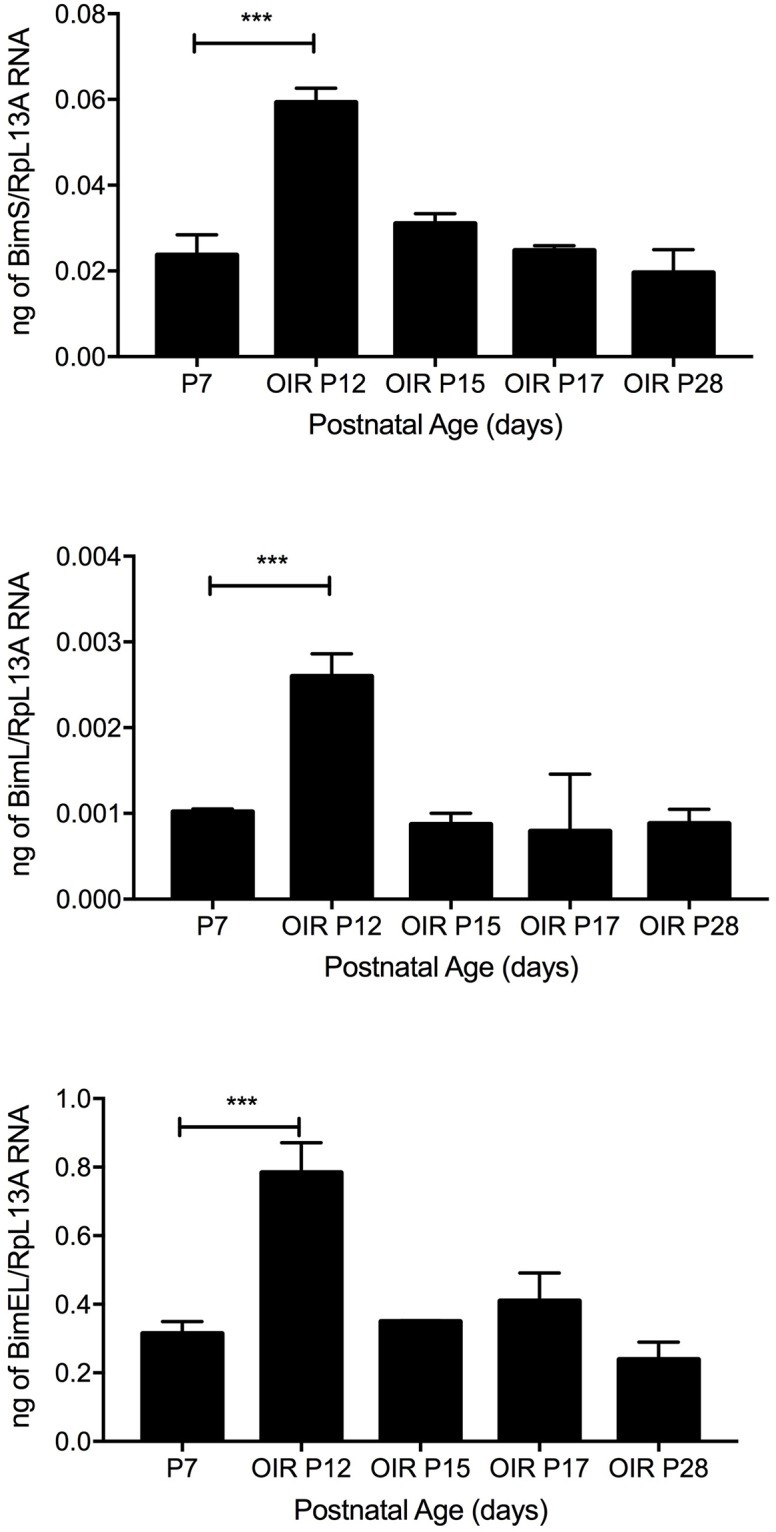
Bim expression increases during hyperoxia.Wild-type mice were subjected to OIR at P7. RNA was prepared from the retina of wild-type mice at the noted times. Bim expression was analyzed by qPCR. Please note increased Bim expression with hyperoxia (P12). Samples were done in triplicate and repeated twice. (n = 6, ***P<0.001).